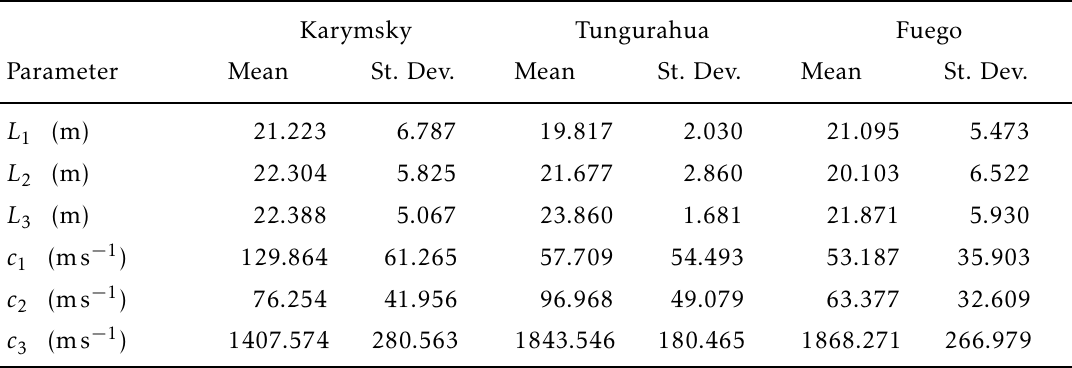
Table 1 – Output parameters from the three-layered conduit model [Garcés 1997]. Parameters were calculated using an iterative Nelder-Mead algorithm. The values shown are averaged across 12 records from Karymsky, 30 at Tungurahua, and 33 at Fuego.